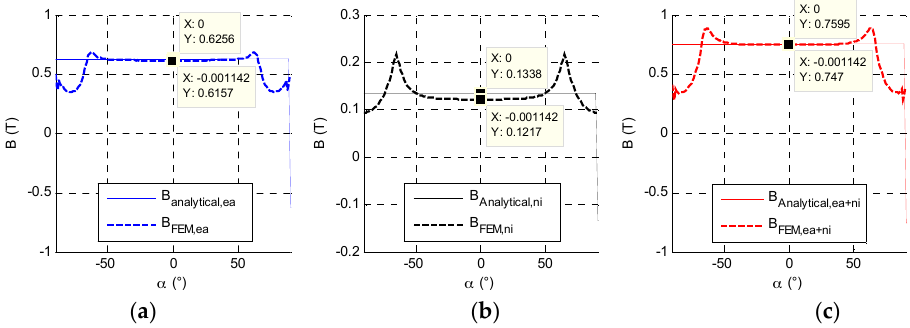
Figure 6. The distributed induction flux density in the air gap: ( a ) magnet induction flux density B ea ; ( b ) the magnetomotrice force flux density B ni ; ( c ) sum of both B e on a complete pole pitch.